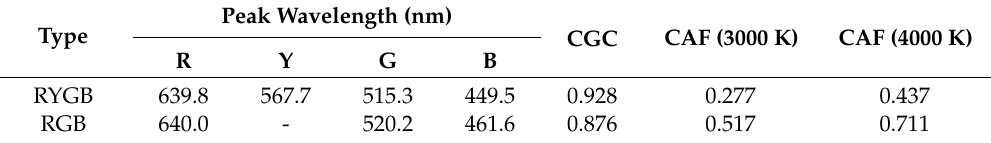
Table 1. Central wavelengths and performance of two micro-LED displays.